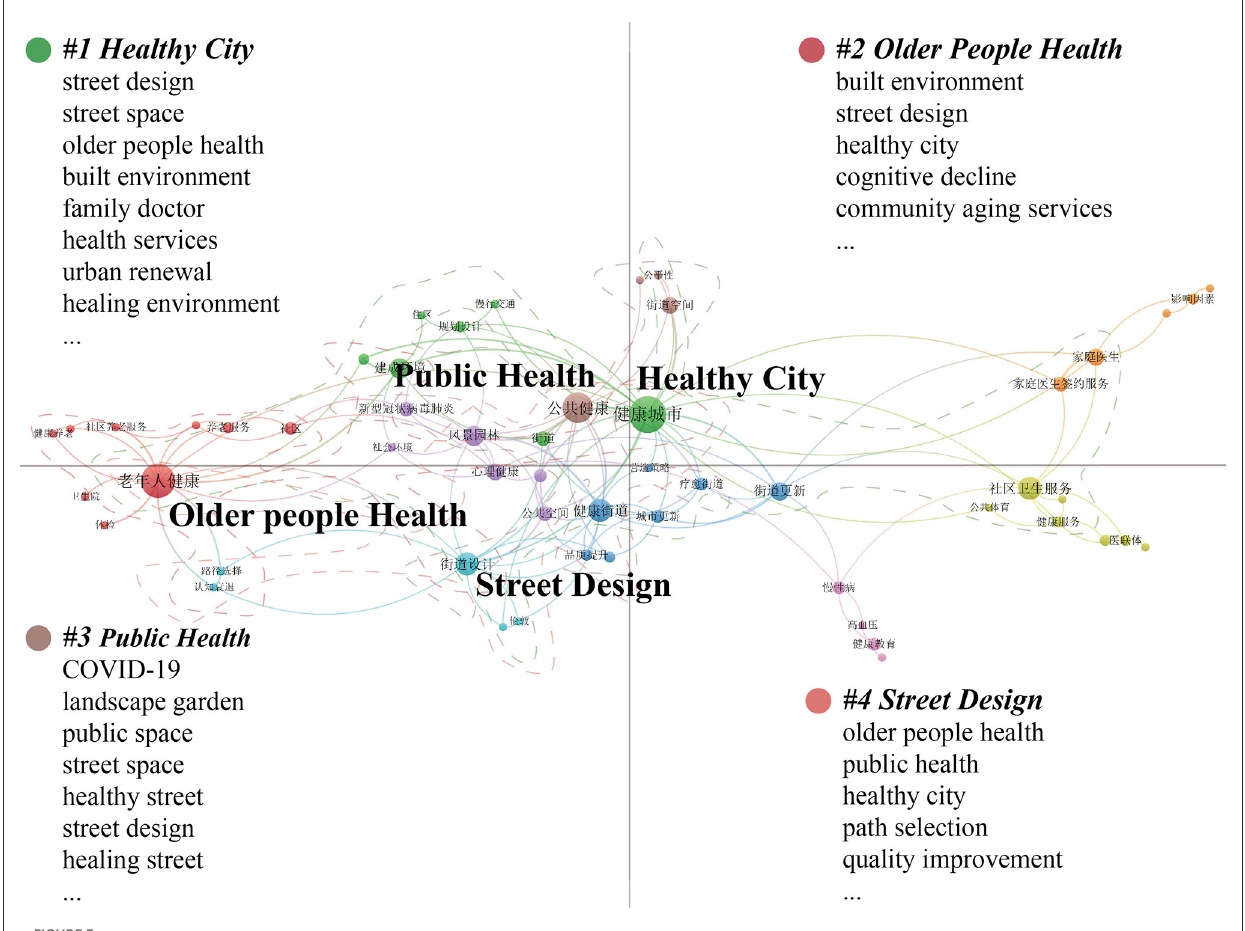
FIGURE3 Major thematic focus areas for